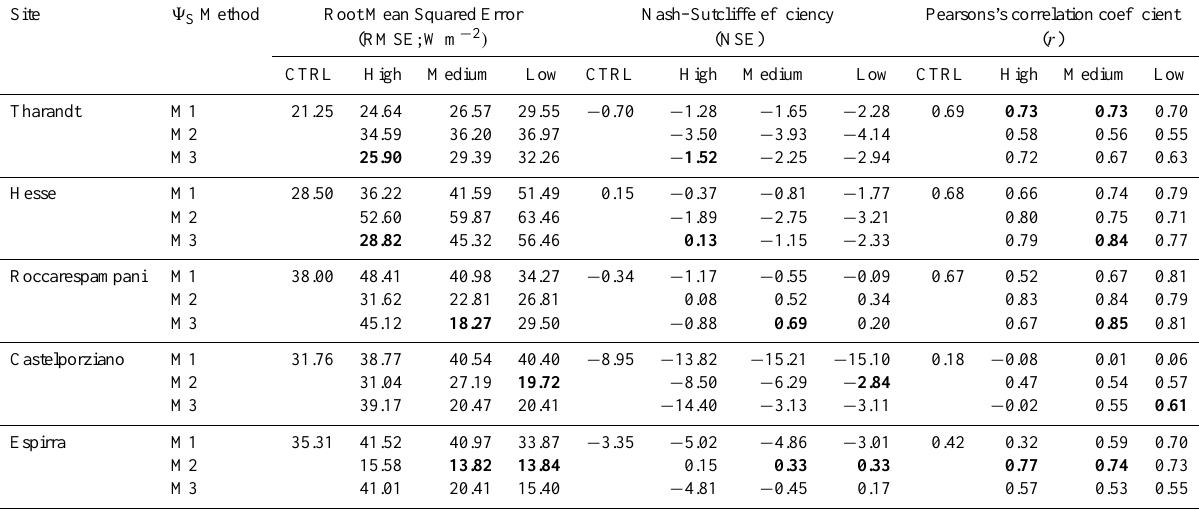
Table 4. Summary statistics of modelled and observed latent heat (LE) at the five FLUXNET sites during the main drought period (1 June to 31 August 2003). The results of the three parameterisations, which represent a spectrum of behaviour, ranging from high to low drought sensitivity, are shown for the three tested approaches (M1–M3) to obtain a weighted estimate of soil water potential ( (cid:57) S ) across CABLE’s soil layers. M1 uses a root-biomass weighted soil water content converted to (cid:57) S , M2 calculates (cid:57) S by integrated soil water content over the top 1.7m of the soil, and M3 is calculated using a dynamic weighting across soil layers. Sites have been ordered to show a mesic-xeric transition between sites (Tharandt to Espirra). For each site the best performing model simulation has been highlighted in bold.